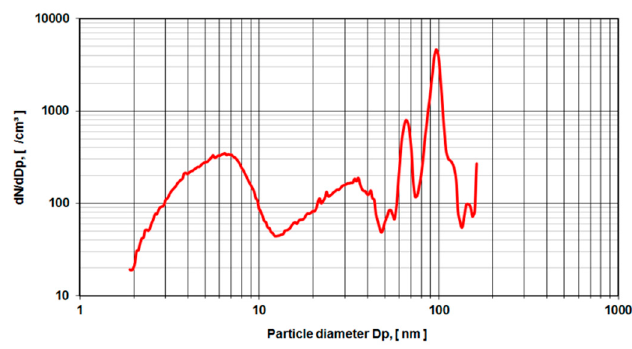
Figure 8. Reference silica spheres with 102 nm nominal diameter, no dilution.